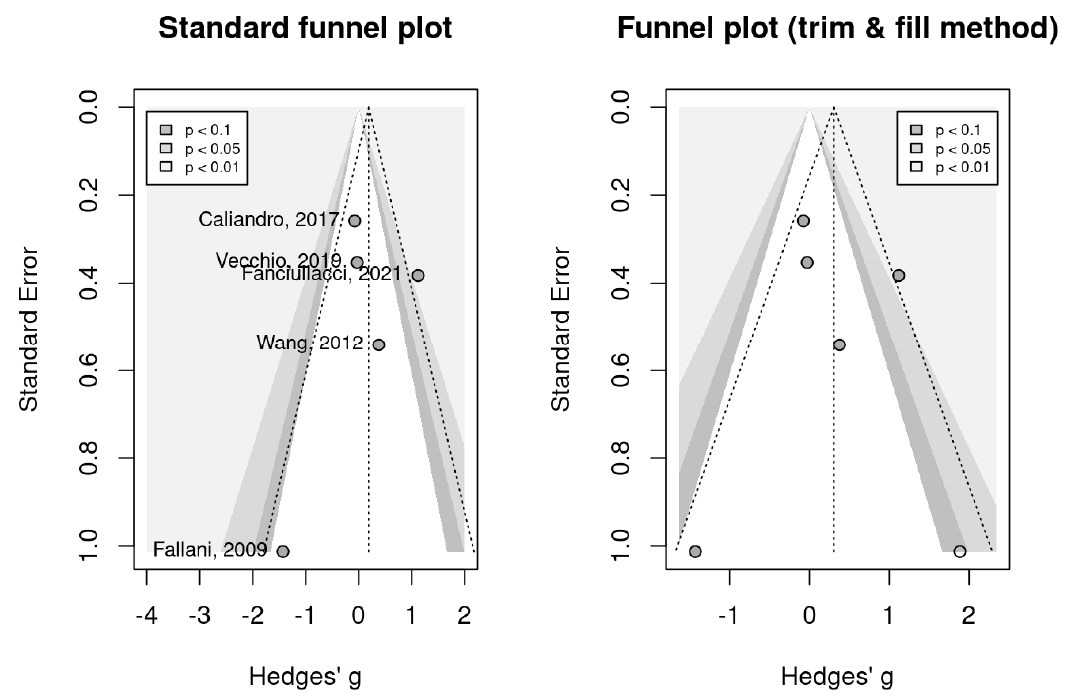
Figure A6. Publication bias funnel plots. Grey scale bands: significance levels from p < 0.1 (darker gray) to p < 0.01 (lighter gray) [7,8,10,12,13].